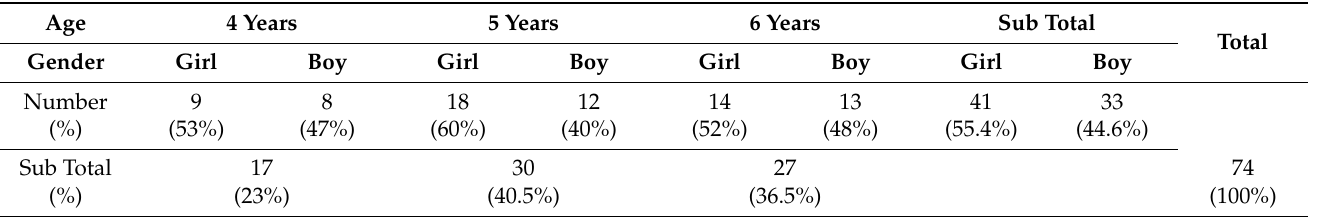
Table 1. Description of the